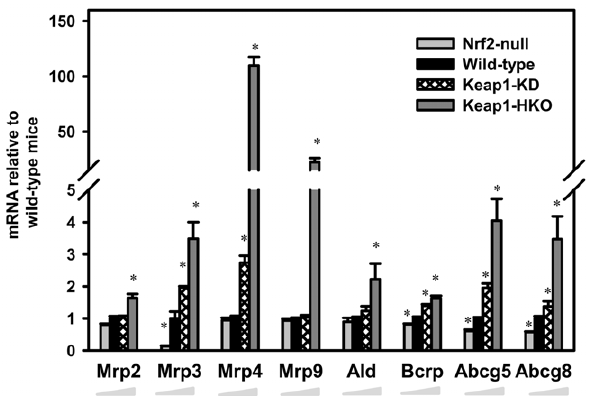
Figure 6. Messenger RNA of efflux transporters in a ‘‘gene dose-response’’ model. Data of Nrf2-null, Keap1-KD, and Keap1-HKO mice are normalized by the value of wild-type mice and presented as Mean 6 S.E.M. of three mice per group. Asterisks (*) indicate statistically significant differences from wild-type mice (p , 0.05).